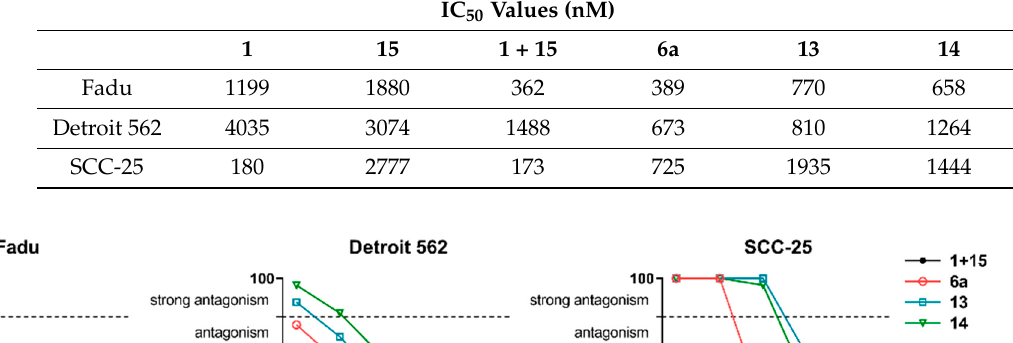
Table 1. IC 50 values of hybrids ( 6a , 13 and 14) and reference fragments (1 and 15) as single agents and in 1:1 combination, after 72 h treatment and 72 h postincubation. IC 50 values were determined by GraphPad Prism 8 software (nonlinear regression, variable slope, best fit values are presented, n = 4).